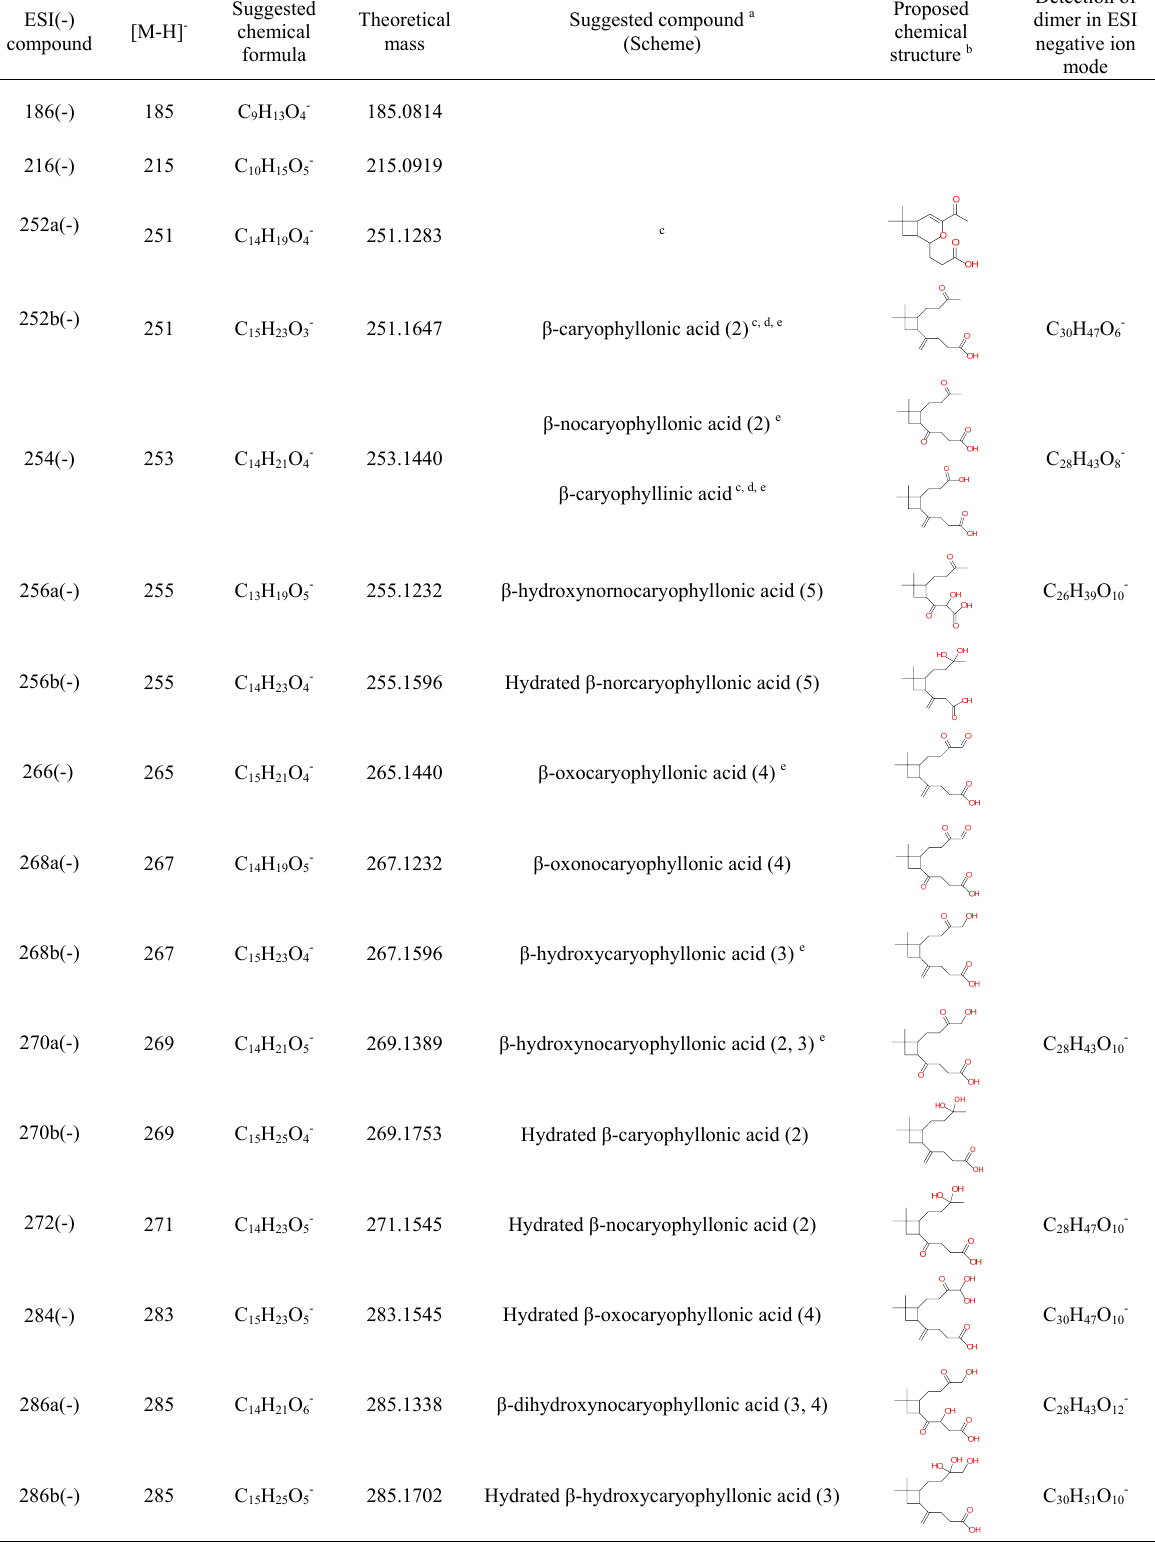
Table 3. Compounds detected by ESI in the negative ion mode in the series of β -caryophyllene/NO X irradiation experiments